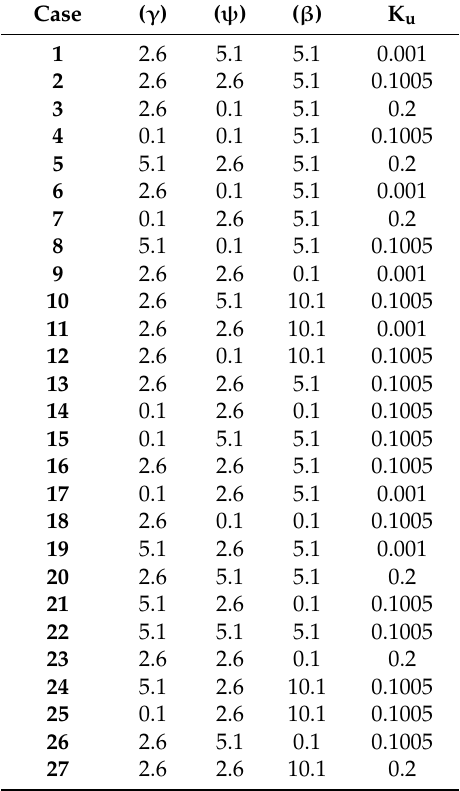
The 27 suggested sets of pitting parameters obtained from the response surface methodology (RSM) technique to be able to predict the Chi-square value ( χ 2 ) for each experiment: (Mg–1.2Zn–0.5Ca—immersion